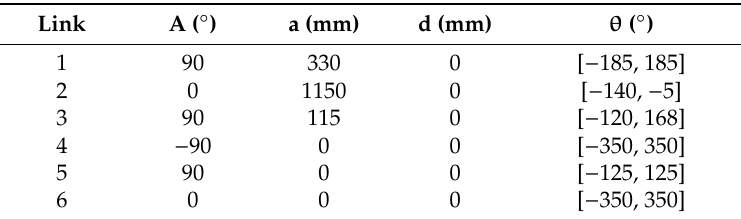
Figure 2. Robot entity and simulation model. ( a ) Schematic description of the KUKA KR210 R2700 robot architecture; and, ( b ) a simulation model of the KUKA KR210 R2700 robot using the Monte Carlo method in MATLAB 2018a.